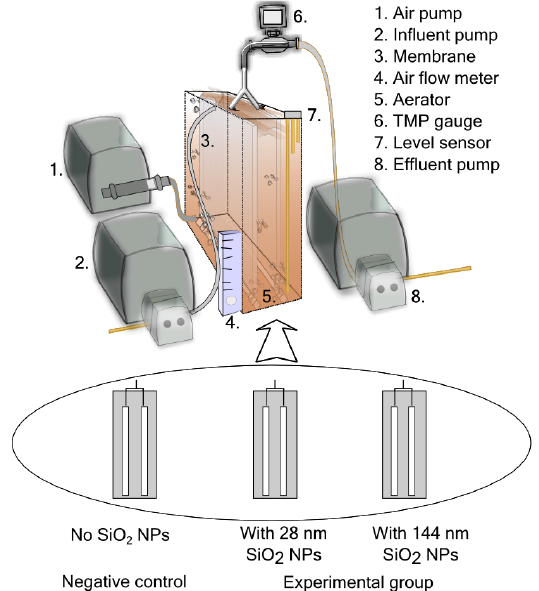
Figure 1. Schematic of the lab-scale membrane bioreactor (MBR) used in the continuous experiment.